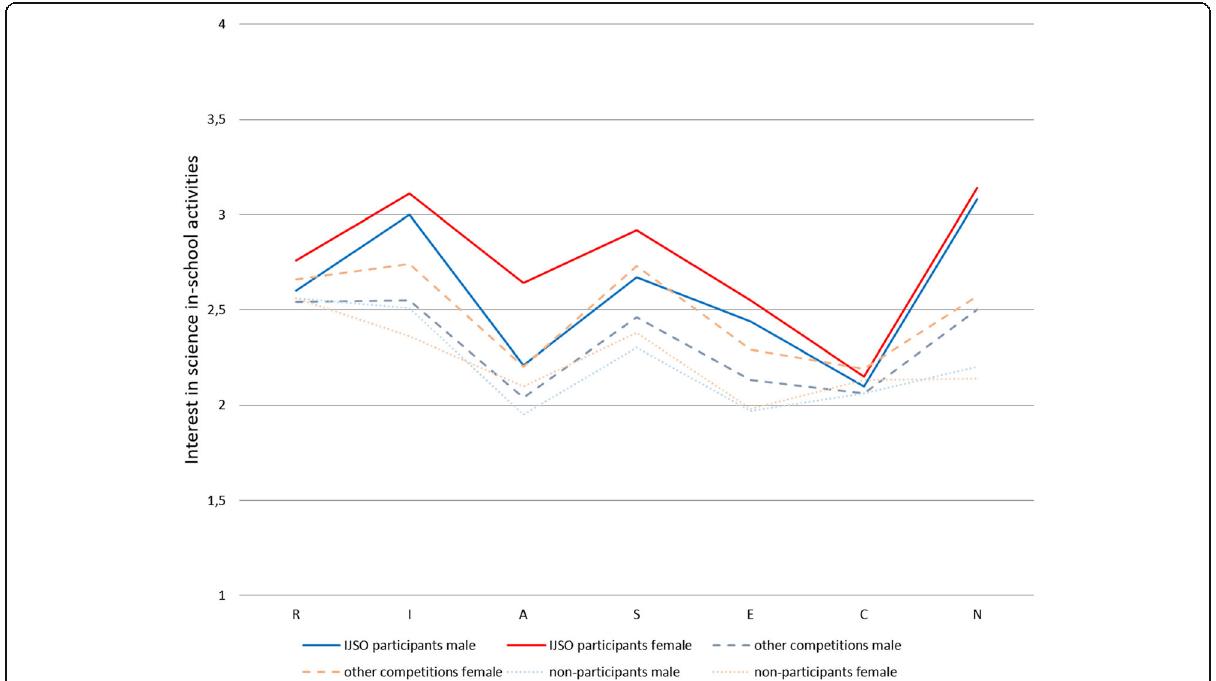
Fig. 3. Gender profiles of interest in science in-school activities. Interest profiles of IJSO-participating, non-participating, and in other science and mathematics participating girls and boys in realistic, investigative, artistic, social, enterprising, conventional, and networking science